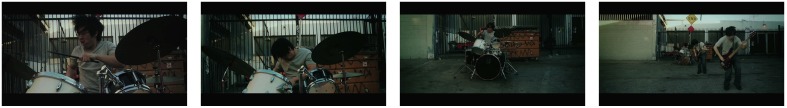
The four screenshots represent the timeline of the long-running drums sequence; the first frame also illustrates the single event contained within the 1-s stimulus version.